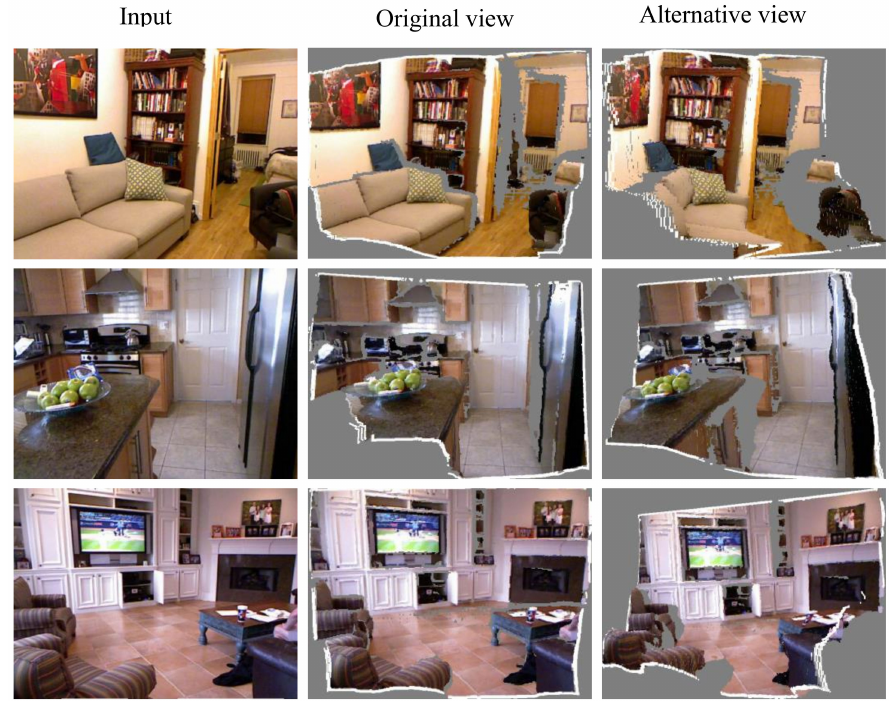
Figure 12. 3D reconstruction results by leveraging our